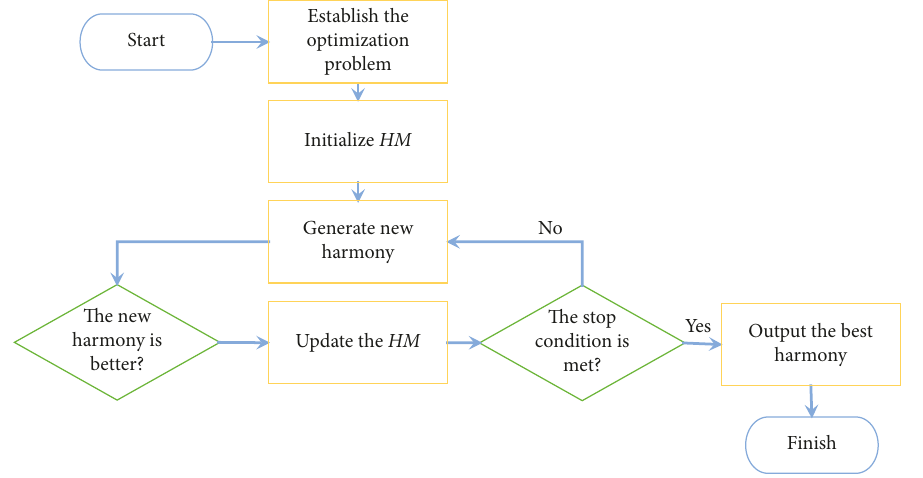
Figure 3: Flowchart of harmony search